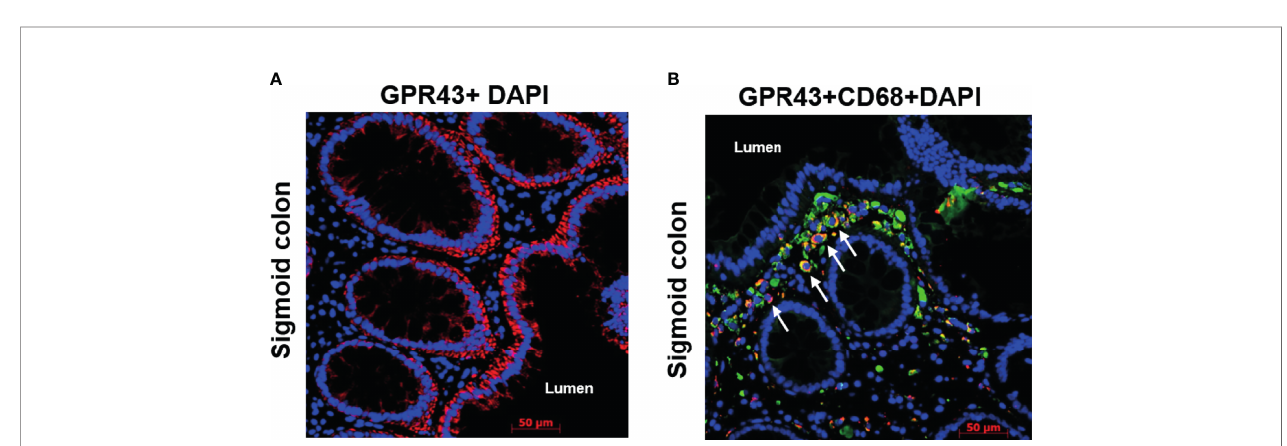
FIGURE 5 | Immuno fl uorescence of GPR43 of a representative patient biopsy. Time from transplant to biopsy: 3.5 years, no GvHD at the time of biopsy. (A) GPR43 staining in the sigmoid colon of a patient. GPR43 is labelled with AlexaFlour (AF) 594 (red). (B) GPR43 and CD68 co-staining in the sigmoid colon of a patient. GPR43 is labelled with AF594 (red) and CD68 is labelled with AF488 (green). White arrow indicates colocalized signals. Nucleus is counterstained with DAPI (blue). Scale bar: 50 µm.